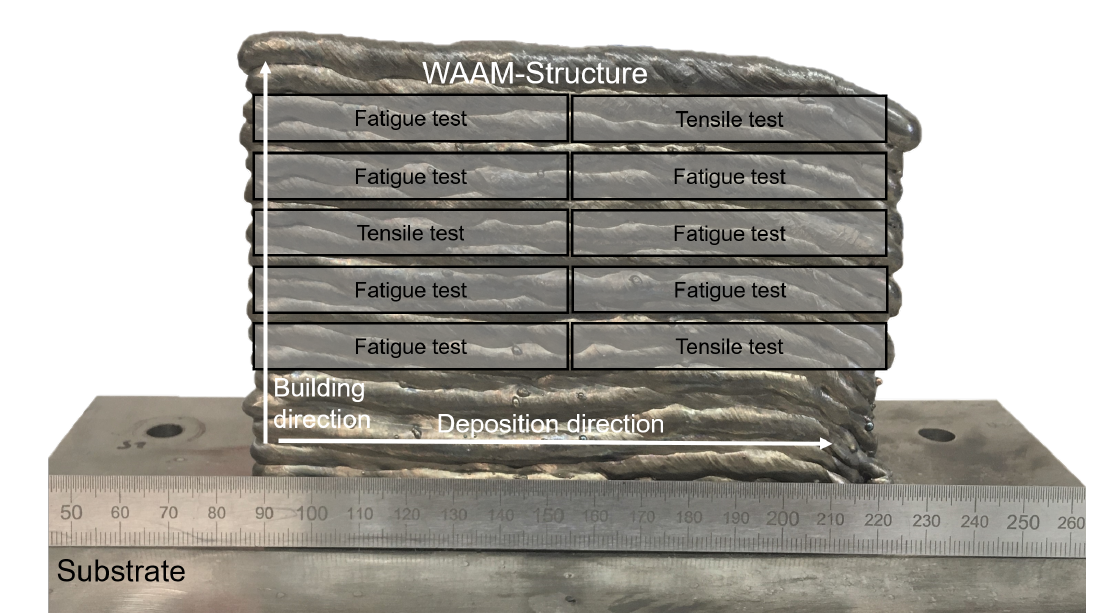
Figure 2. Additively manufactured structure for experiments and schematic specimen positions.